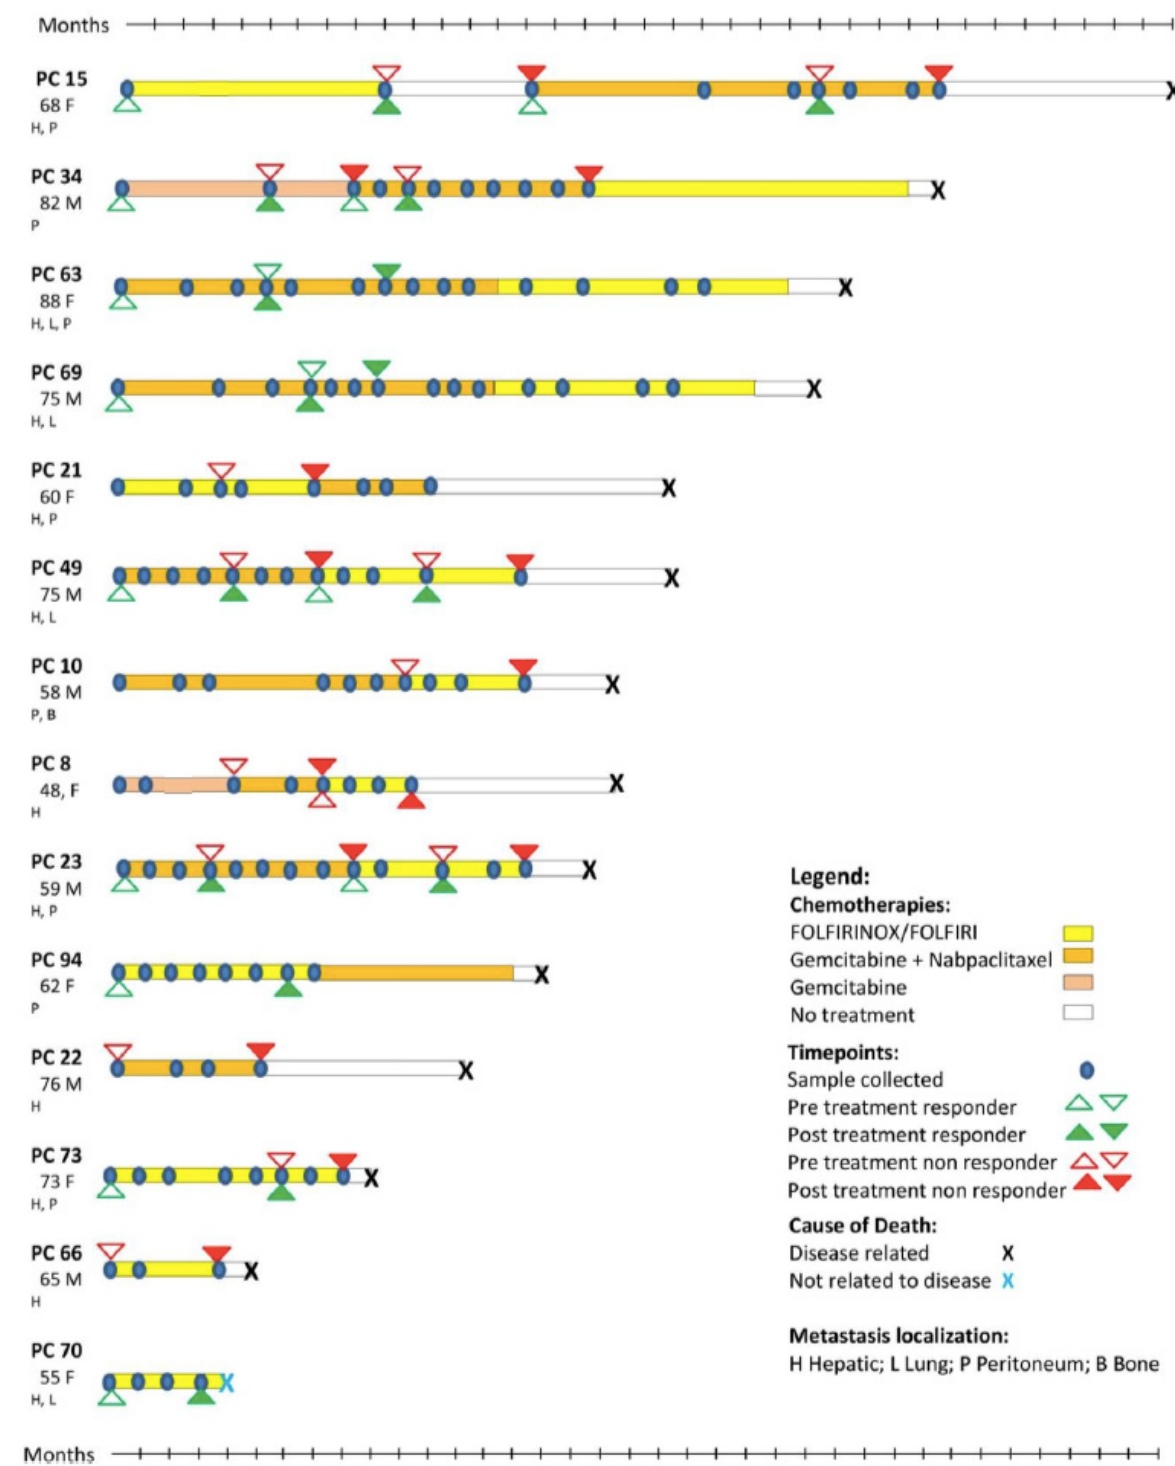
Figure 1. Patients and their respective treatments. Depiction of the metastatic profile, treatment pro- tocols, and sample collections from patients analyzed in our study. PDAC patient (PC) number, age, gender (M,F), and metastatic location(s) are provided.